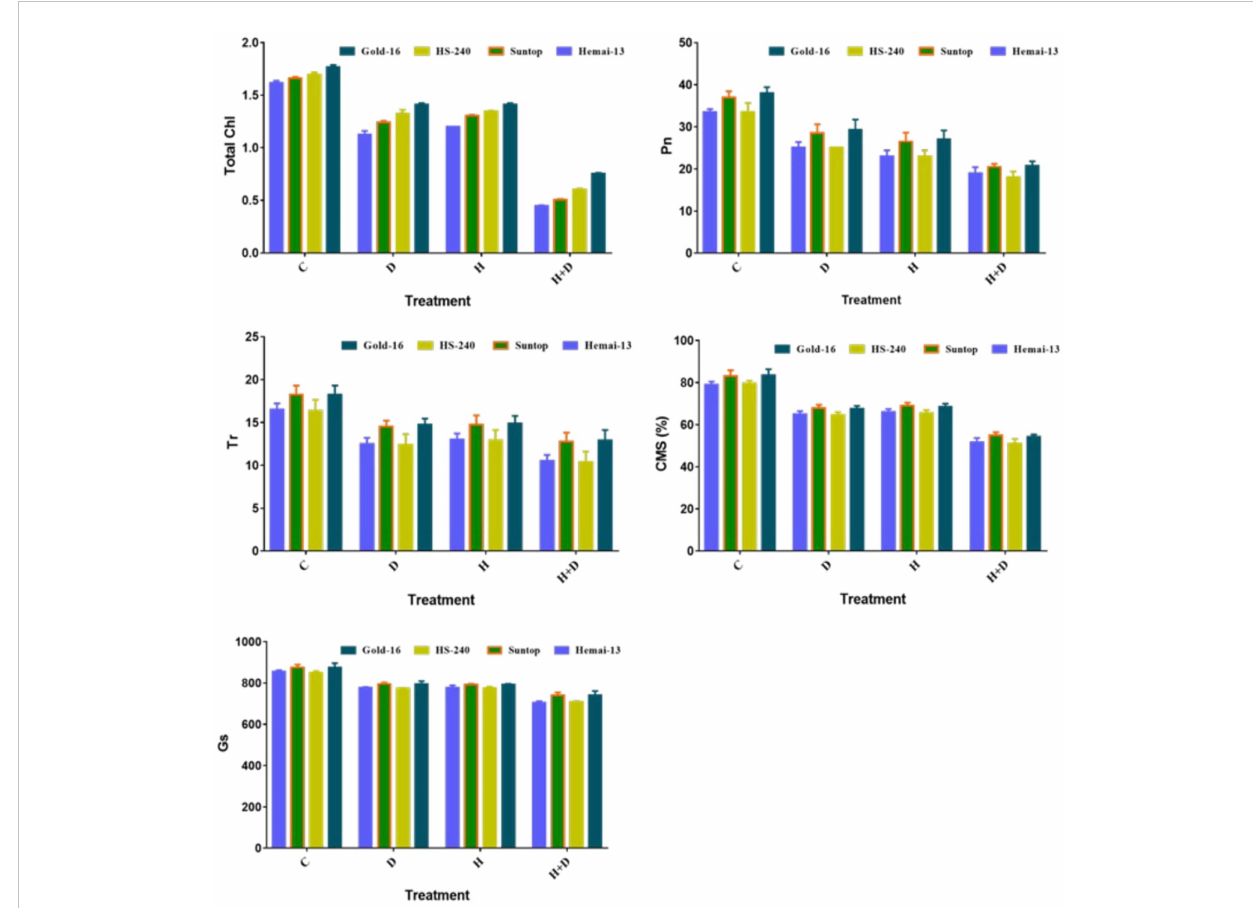
FIGURE 2 Variation in physiological attributes of wheat cultivars due to individual and combined treatments of drought and heat stress. Photosynthesis rate (Pn); transpiration (Tr); cell membrane stability (CMS); stomatal conductance (Gs). Values in graph are means averaged after every 4 days of treatment application during the two-factorial tri-replicate experiment at a p -value ≤ 0.05 . *Units: Total chlorophyl l content (g kg – 1 ); Pn ( m m – 2 S – 1 ); Tr (mmm – 2 S – 1 ); Gs (mmm – 2 S – 1 )